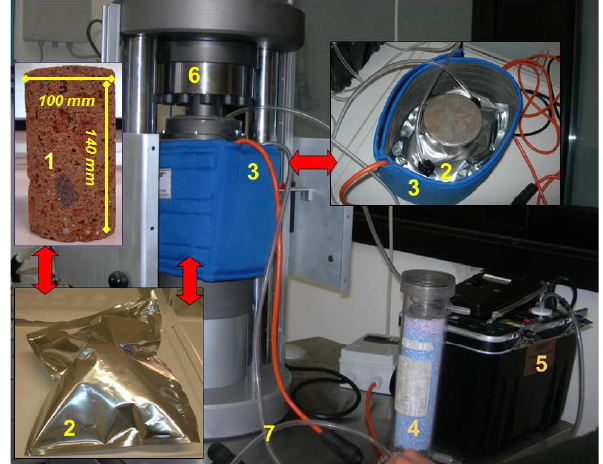
Figure 1. Experimental setup for the detection of 222 Rn and 220 Rn activity concentrations from rocks under uniaxial deformation. The system consists of: rock sample (1), DryPack accumulation cham- ber (2), digitally controlled heating belt (3), desiccant (4), RAD 7 radon monitor (5), uniaxial press (6), and vinyl tubing (7). Arrows connect the different sections of the experimental system to give a complete view of it. See text for